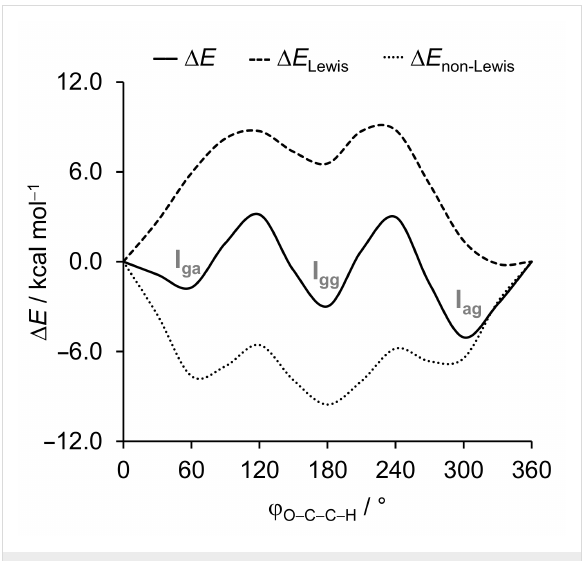
Figure 2: Optimized structures of conformers I gg (left), I ag (middle), and I ga (right), along with the relative electronic and Gibbs free energies (in kcal mol − 1 ) in the gas phase and in water solution (in parentheses), computed at the ω B97X-D/6-311++G(d,p) level of theory.